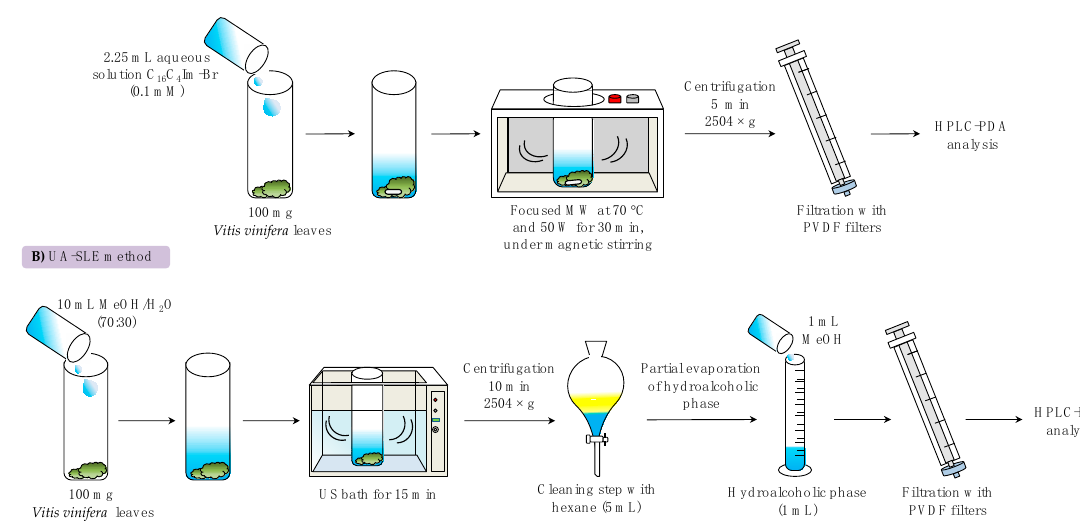
Figure 3. Scheme of the extraction procedures from Vitis vinifera leaves: ( A ) proposed MA-SLE method and ( B ) UA-SLE method used with comparison purposes, which was previously reported for this specific application [15].